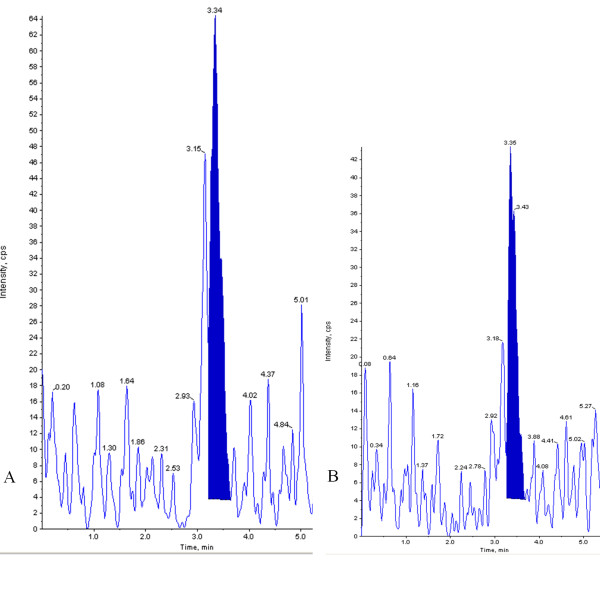
LC-MS/MS chromatograms showing levels of LTB4 in human WBC’s. A: Control group, B: PHF treated.